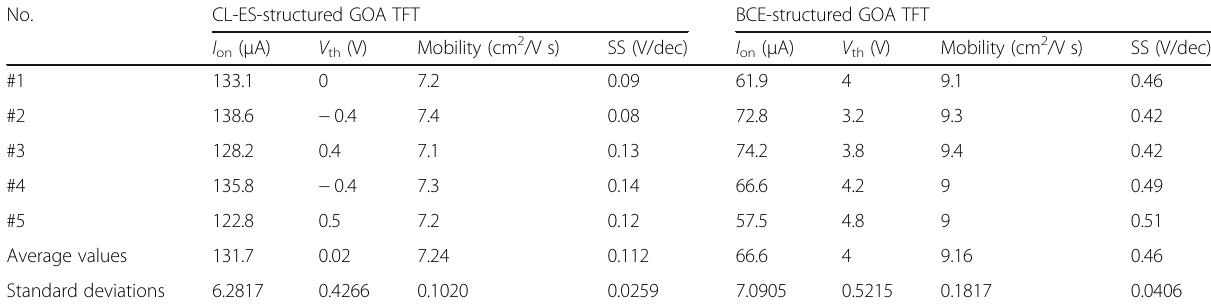
Table 2 Five locations of initial I - V transfer characteristics for the CL-ES- and the BCE-structured GOA TFTs